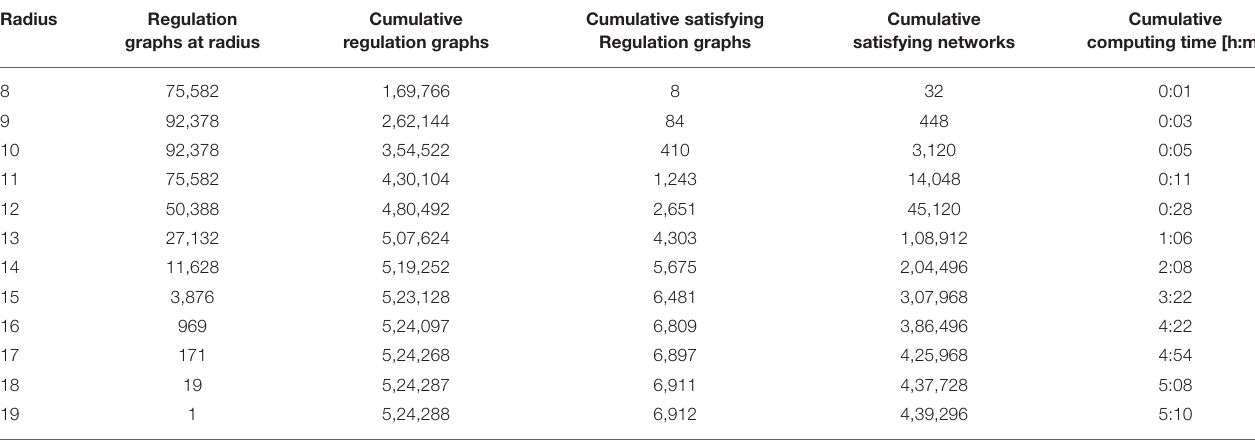
TABLE 4 | Satisfying R-graphs and Boolean networks found by Griffin for the center-radius exploration strategy applied to A. thaliana sepal model. Radius Regulation Cumulative Cumulative satisfying graphs at radius regulation graphs Regulation graphs